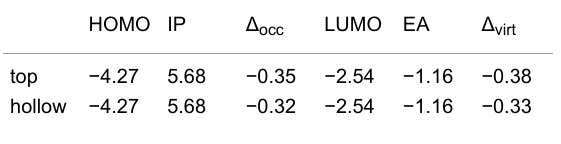
Table 1: Kohn–Sham HOMO and LUMO, ionization potential (IP), electron affinity (EA) and image charge correction for occupied Δ occ and Δ virt unoccupied orbitals. All quantities are in